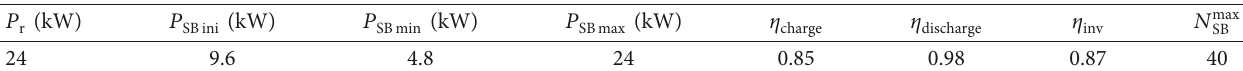
Table 6: Battery